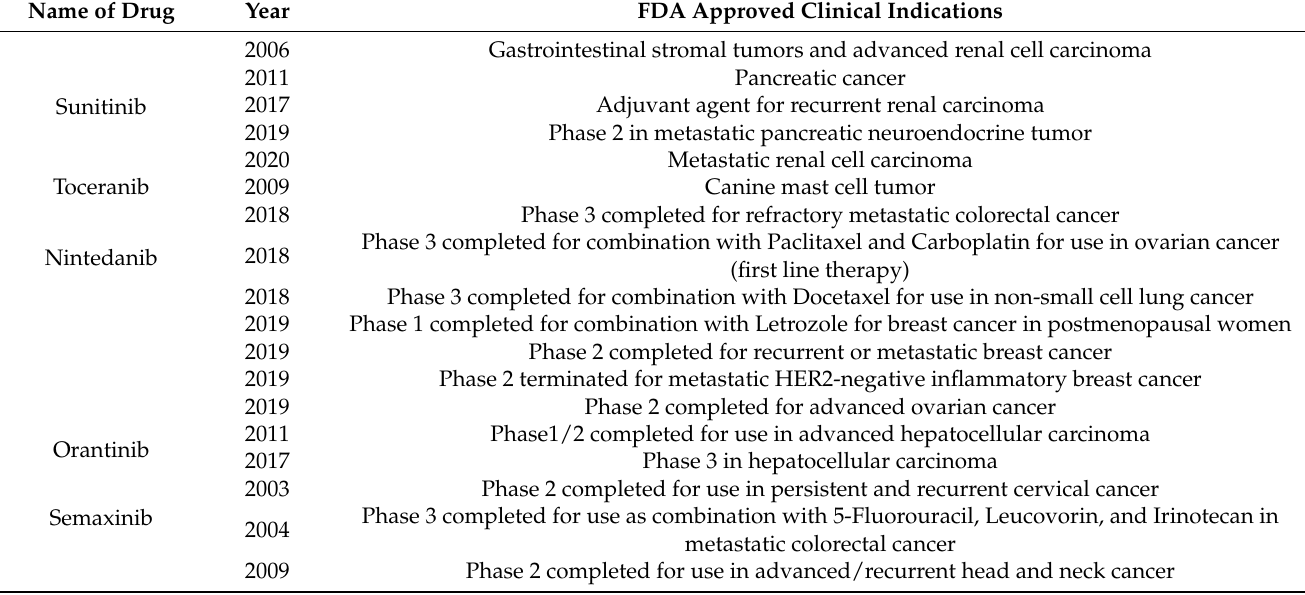
Table 2. Summary of clinical trials and approval for isatin derivatives according to ClinicalTrials.gov database [95].